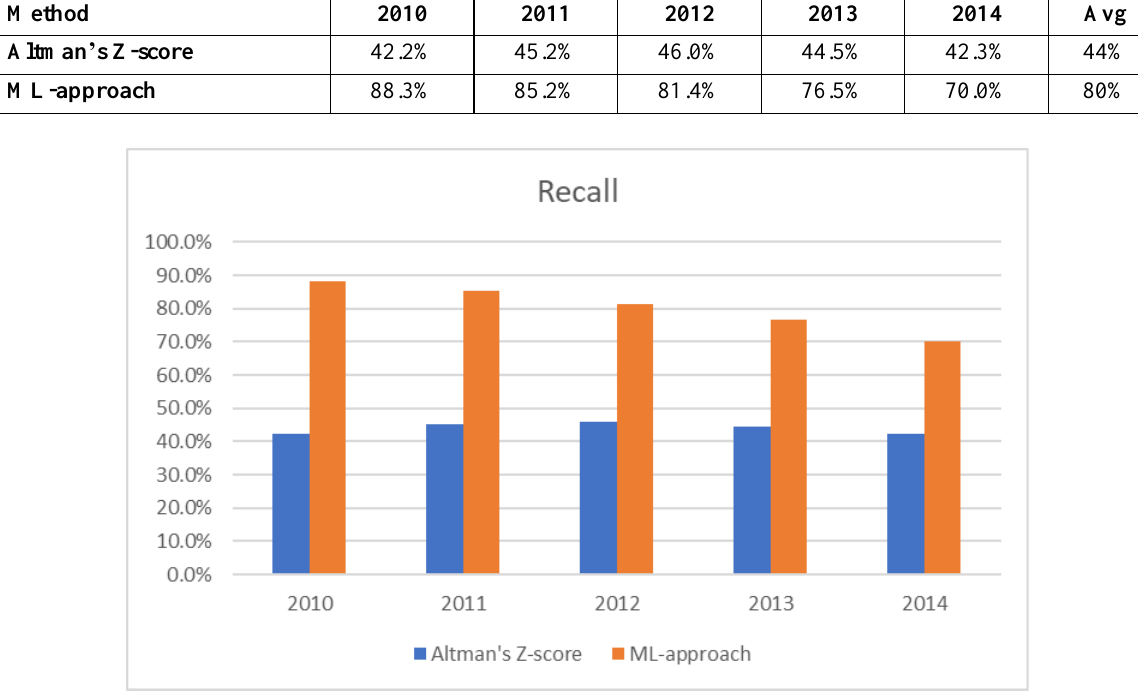
Figure 2. Recall: Altman’s Z-score VS ML-approach